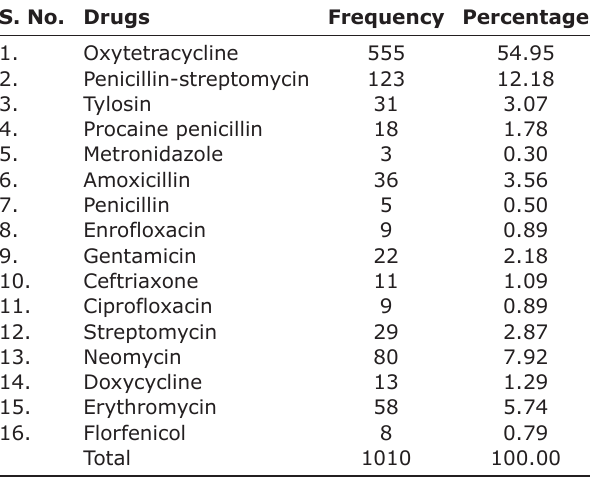
Table-5: Frequency and percentage of use of antibiotics in the